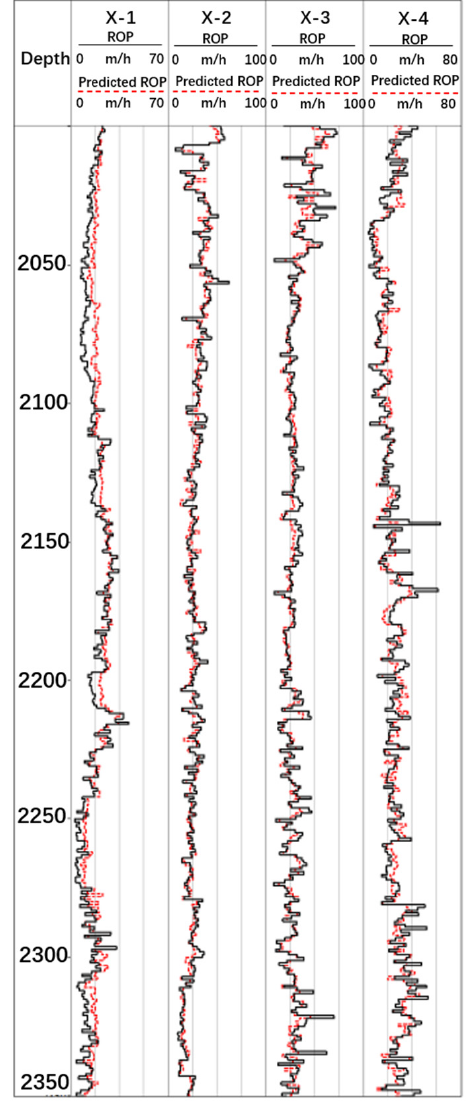
Figure 17. Generalization ability test.